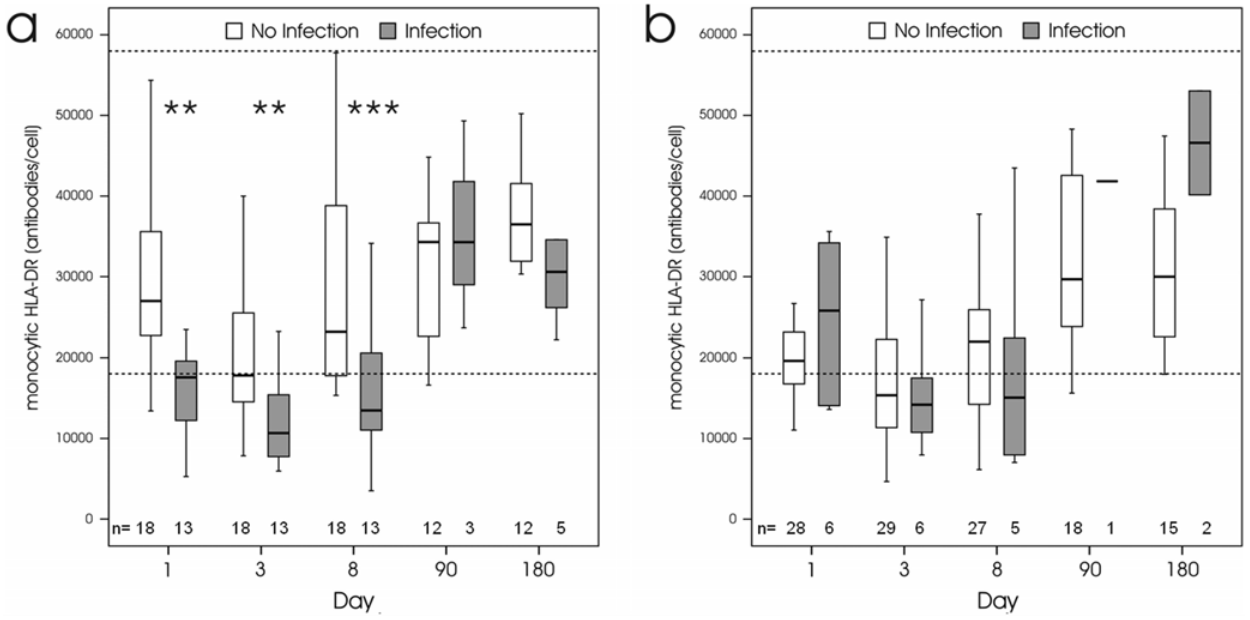
Figure 6. Monocytic HLA-DR expression in patients with and without infections. a: In the placebo group, monocytic HLA-DR expression in patients with infections is significantly reduced compared to patients without infections at day 1 (** p =0.003), 3 (** p =0.005), and 8 (*** p , 0.001) days, but not at day 180 after stroke. b: In the verum group, monocytic HLA-DR expression is not significantly different between patients with and without infections. Dashed lines indicate the upper and lower reference range for monocytic HLA-DR levels in healthy individuals (5% percentile=18036 mAb/cell; 95% percentile=57958 mAb/cell).